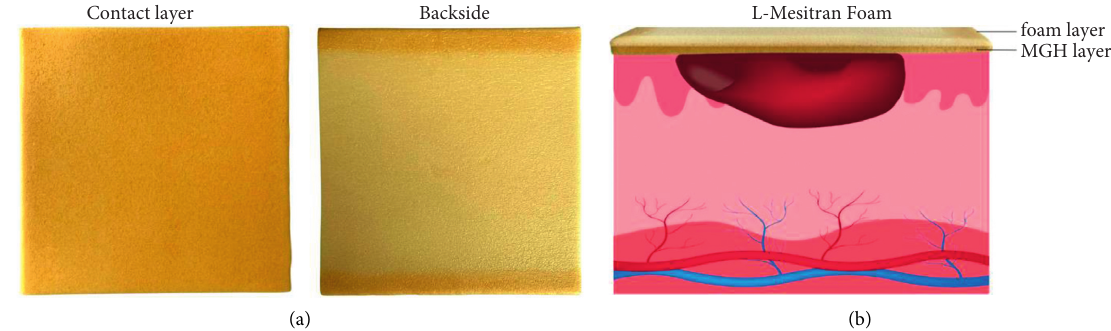
Figure 1: L-Mesitran Foam dressing. (a) Picture of the L-Mesitran Foam dressing showing the two layers: contact layer covered with L- Mesitran Soft and the backside being the foam dressing. The dimensions of the dressing are 10cm in length, 10cm in width, and 3mm thick. (b) Schematic presentation of L-Mesitran Foam covering a wound. The MGH layer creates a moist wound environment and attracts the exudate towards the foam layer which subsequently absorbs it. The foam forms a physical barrier for invading pathogens and protects the wound from mechanical